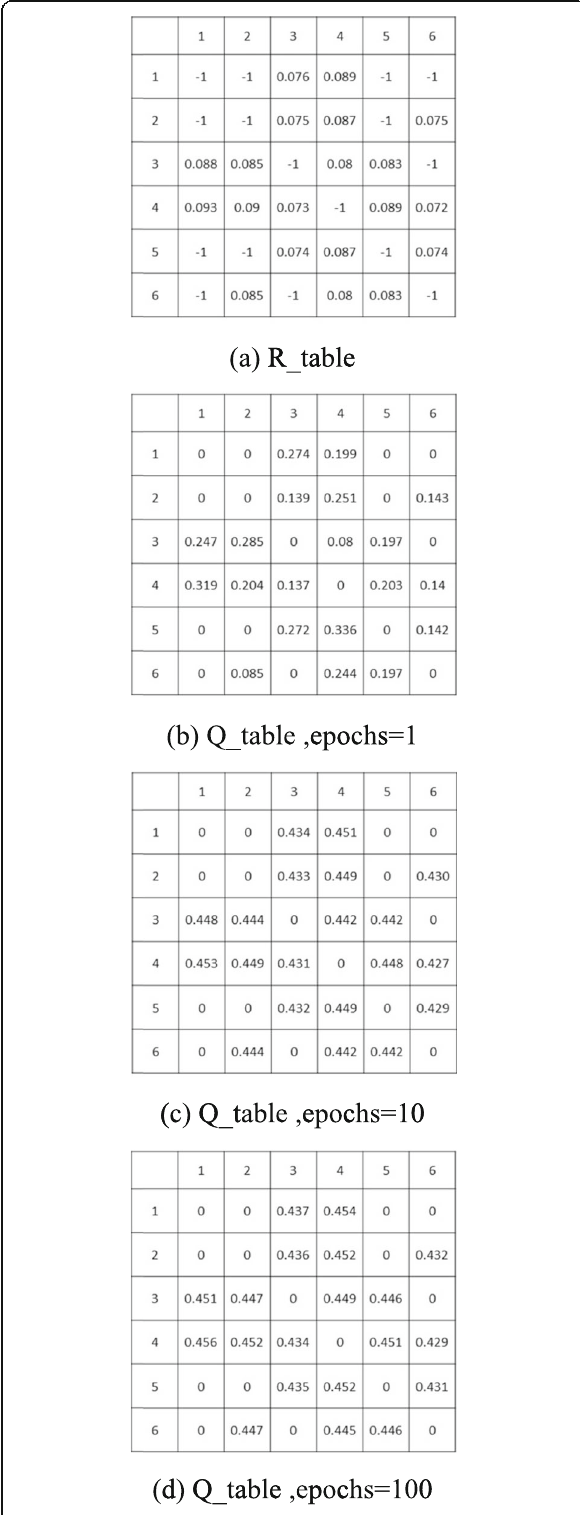
Fig. 5 a is a R_table, the first row of the R table represents the name of the road segment, and the value in the table represents the return value of one road matching to another road, where the value of − 1 indicates that the two road segments cannot communicate. Q table is shown in b – d , where different